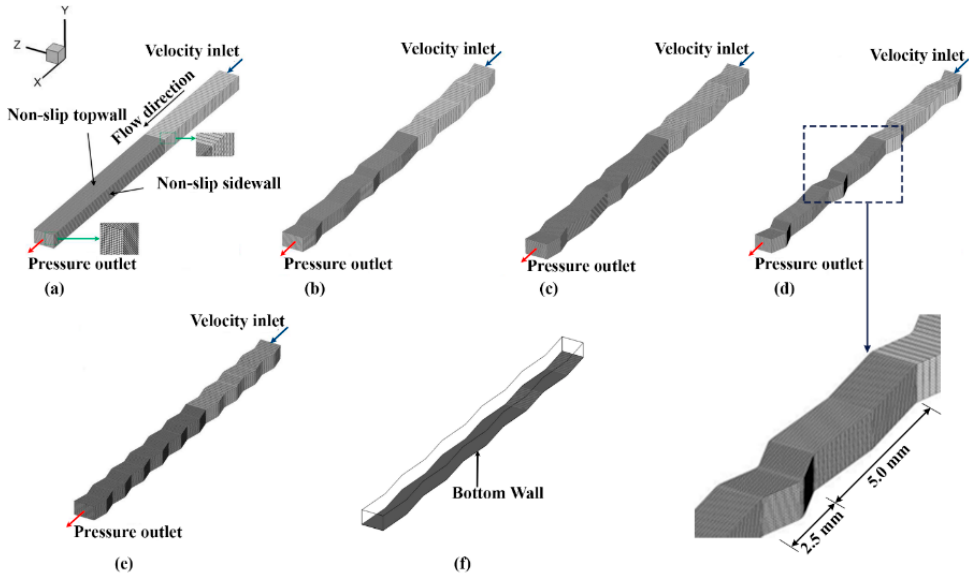
Figure 1. Computational domain of geometric channels ( a ) straight ( b ) sinusoidal hybrid (Design 1) ( c ) sinusoidal hybrid (Design 2) ( d ) sinusoidal hybrid (Design 3) ( e ) sinusoidal non-hybrid (Design 4) ( f ) sinusoidal non-hybrid (Design 5).